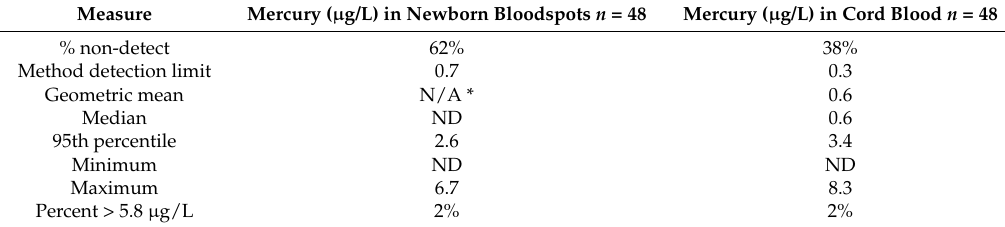
Table 2. Distribution of total mercury ( µ g/L) in newborn bloodspots and cord blood from 48 mother-child pairs in Minneapolis, Minnesota,